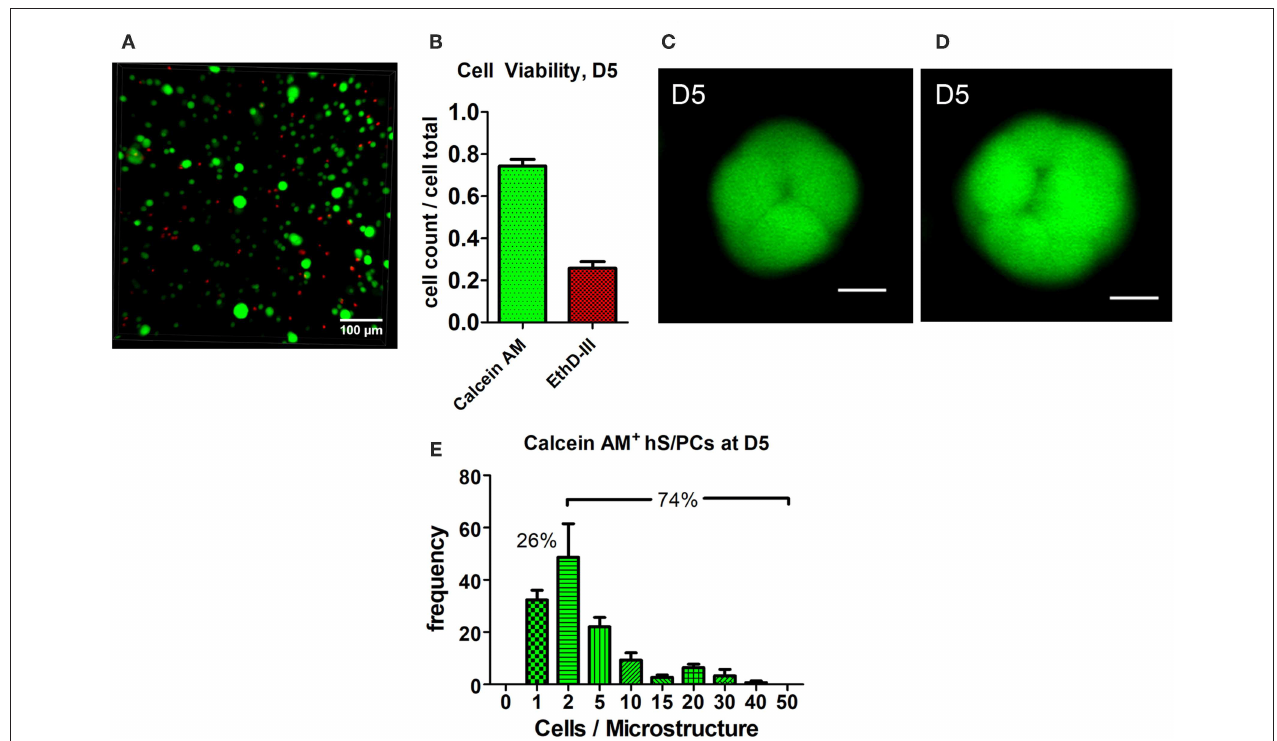
FIGURE 1 | Cluster formation and analysis of microstructure size. hS/PCs cultured for 5 days in HA-based hydrogels formed clusters up to 35 µ m in diameter (A) with 74.3% viability (B) determined by Live/Dead assays. Confocal micrographs were used to quantify cell viability from regions of interest (ROI) of equivalent volumes. Organizing microstructures of 30–35 µ m containing 8 and 16 cells, respectively ( C,D , scale bar = 10 µ m), are readily seen. The distribution of the number of hS/PCs within each microstructure encapsulated in HA-based hydrogel at D5 was measured with respect to microstructure diameter. Approximately 74% of viable cells were in clusters and 26% of viable cells remained single cells (E)